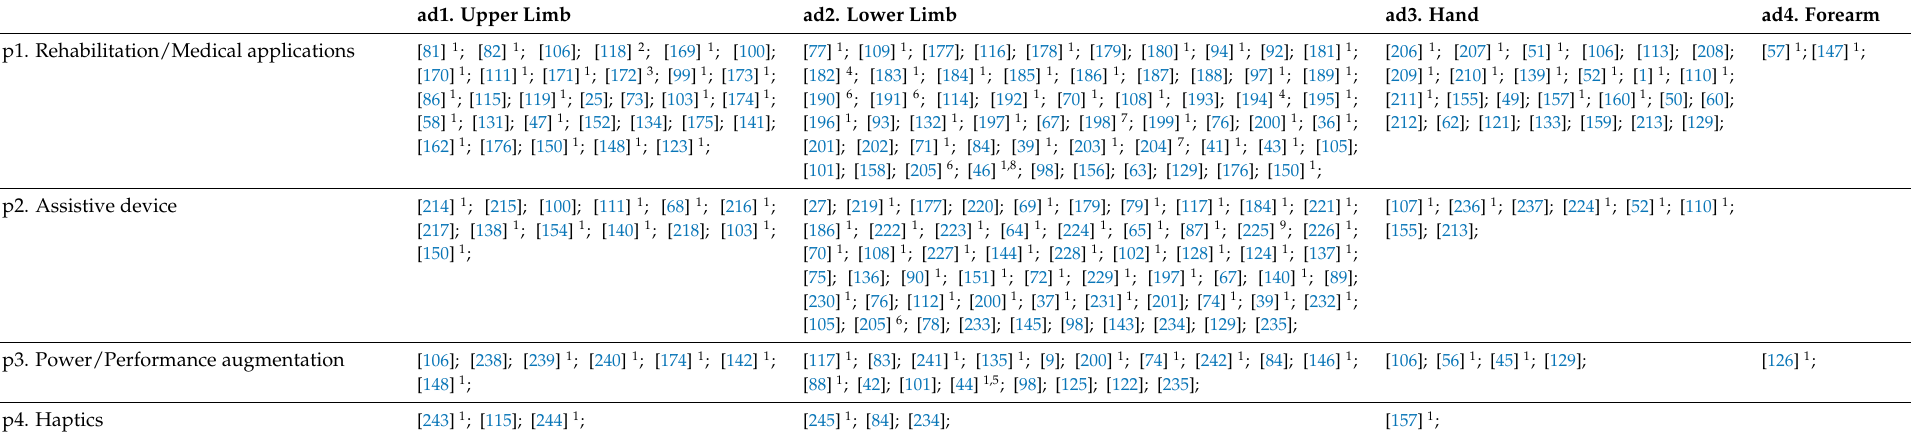
Table A1. Cross analysis of the paper distribution of exoskeleton purpose vs. anatomical district. ad1. Upper